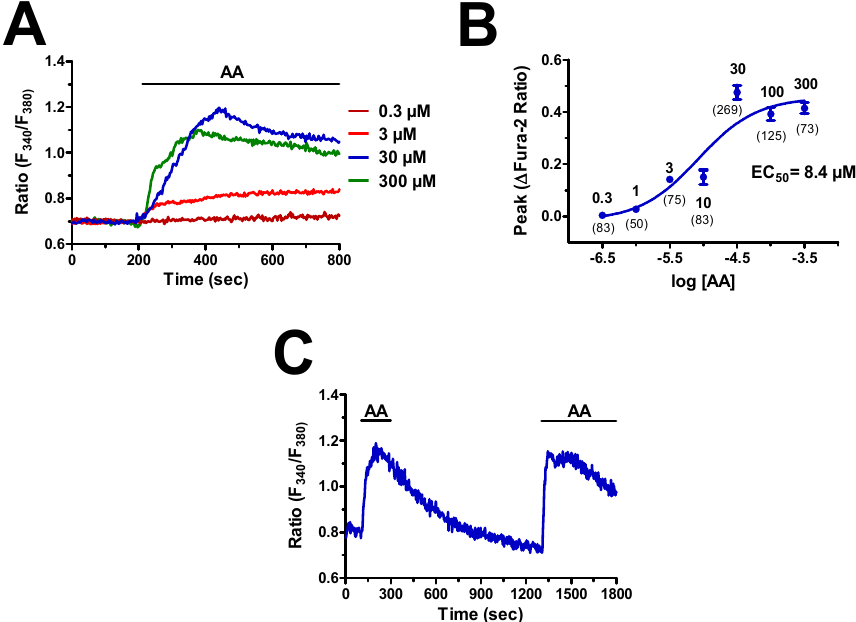
Figure 1. Arachidonic acid (AA) induces an increase in intracellular Ca 2 + concentration ([Ca 2 + ] i ) in hCMEC / D3 cells. ( A ) Intracellular Ca 2 + signals evoked by increasing doses of AA in the hCMEC / D3 cell line. In this and the following figures, agonists and drugs were administered as indicated by the horizontal bars above the traces. ( B ) Dose–response relationship of the amplitude of AA-evoked Ca 2 + signals in hCMEC / D3 cells. The continuous line was obtained from a fit to a sigmoidal concentration-response curve by using Equation (1). ( C ) 30 µ M AA evoked a rapid increase in [Ca 2 + ] i that decayed to the baseline upon agonist removal from the perfusate. When AA was re-added at the same dose, it induced a second elevation in [Ca 2 + ] i that achieved the same peak amplitude as the first one.